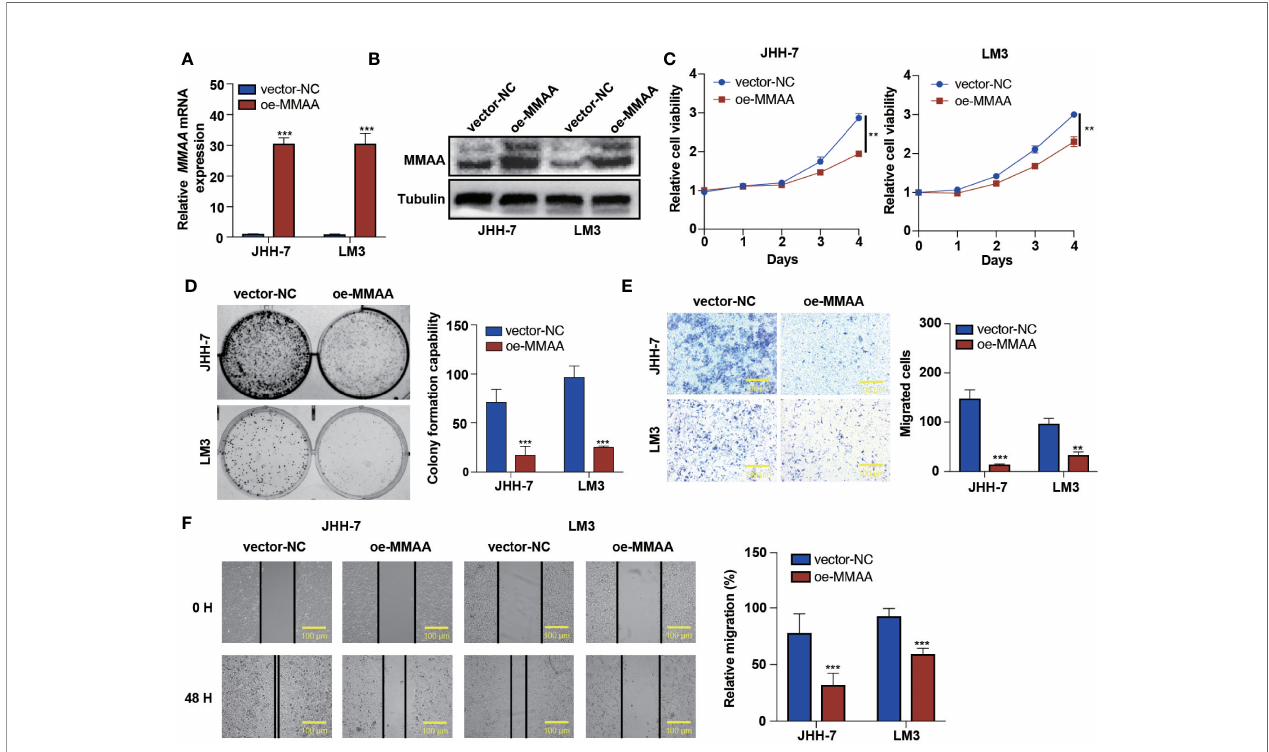
FIGURE 3 | The loss of metabolism of cobalamin-associated A (MMAA) is required for cell proliferation and migration in hepatocellular carcinoma (HCC) in vitro . (A) Analysis of the relative gene expression data for MMAA using qRT-PCR. (B) Analysis of MMAA protein expression using a Western blotting assay. (C) An MTS assay was used to detect the proliferation of HCC cells transfected with OE- MMAA . (D) A colony formation assay was conducted to con fi rm the effect of MMAA overexpression in two different cell lines, and quanti fi cation of the data is shown. (E) The cell migration analysis following MMAA overexpression and quanti fi cation of the data is shown (scale bar, 100 µm). (F) OE- MMAA JHH-7 and LM3 cells both exhibited signi fi cantly decreased cell motility in the wound healing assay, and quanti fi cation of the data is shown (scale bar, 100 µm). ** P < 0.01, *** P < 0.001; three biological repeats per